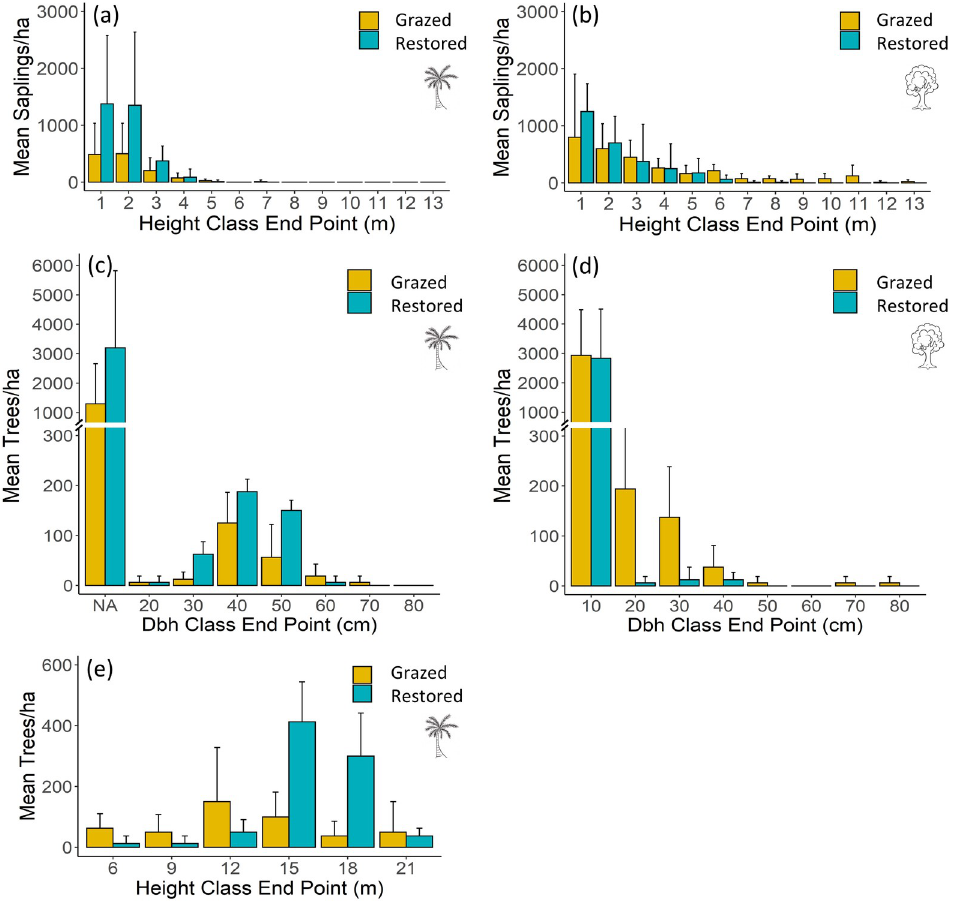
Fig 2. Average number of individuals per hectare in the grazed and restored sections of the reserve for (a) motacu´ saplings separated into 1m height classes; (b) broadleaf saplings separated into 1m height classes; (c) motacu´ saplings and adults separated into 10 cm dbh classes; (d) broadleaf saplings and adults separated into 10 cm dbh classes; and (e) motacu´ adult palms separated into 3m height classes. Note that in (c) acaulescent saplings are represented in the smallest dbh band and the band endpoint has thus been labelled NA on the plot axis. See methods for detail.